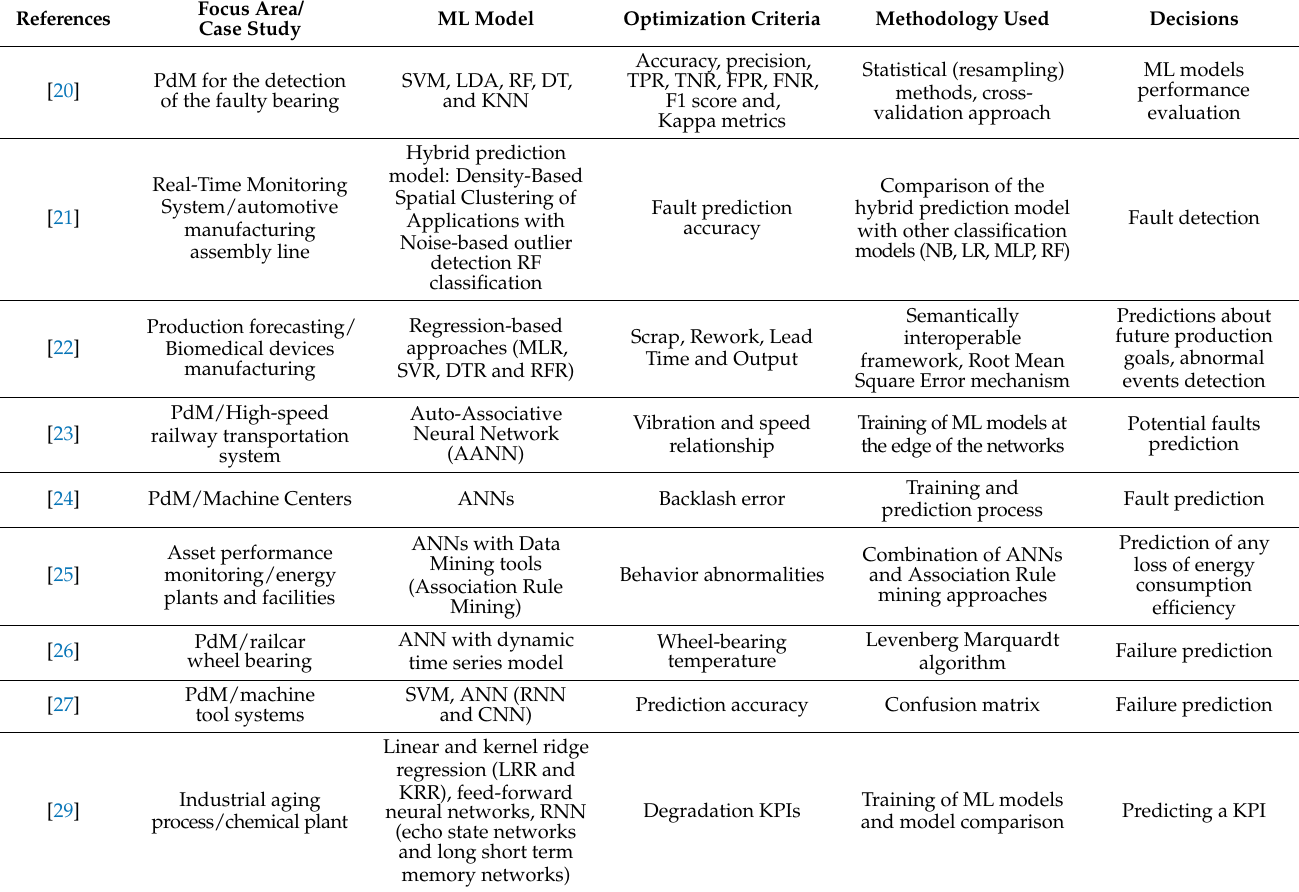
Table 1. Literature